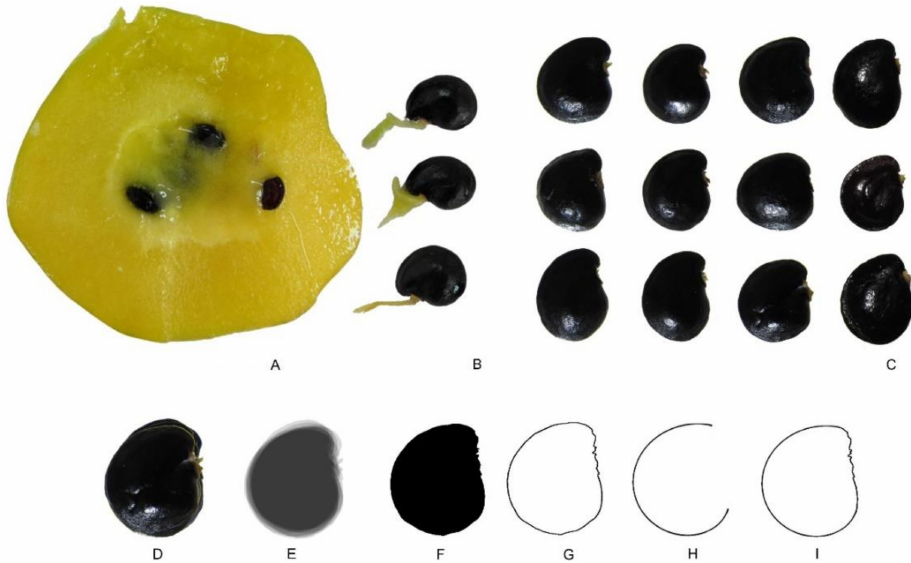
Figure 10. Pereskia bleo . ( A ) An open fruit with mature seeds. ( B ) Three seeds isolated with their funicles. ( C ) Twelve mature seeds. The obtention of the model is shown in the sequence from D to I. The images of nine seeds have been superimposed ( D ) and converted to their silhouettes ( E ) to obtain the average silhouette ( F , G ). ( H ) The curve used as the basis for the model corresponds to the equation r = t − 1/3 with t ∈ [ 1,6 ] , which was the basis for the design of the model. ( I ) Composed model with part of the average silhouette and part of the geometric figure. Bar equals 1